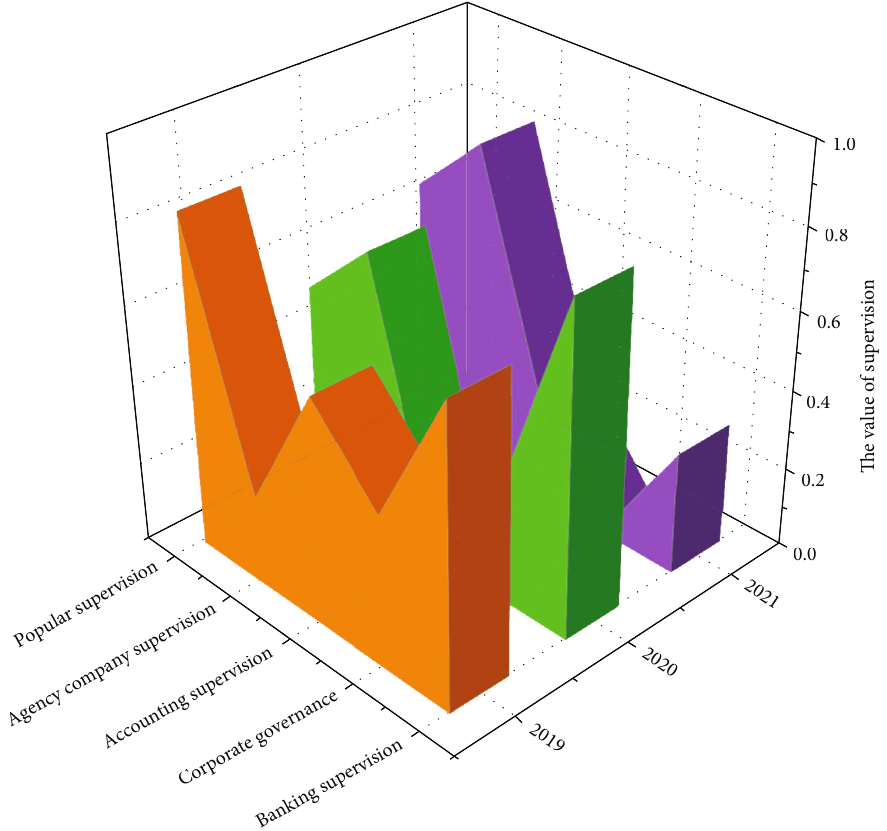
Figure 10: Unit monitoring status in di ff erent